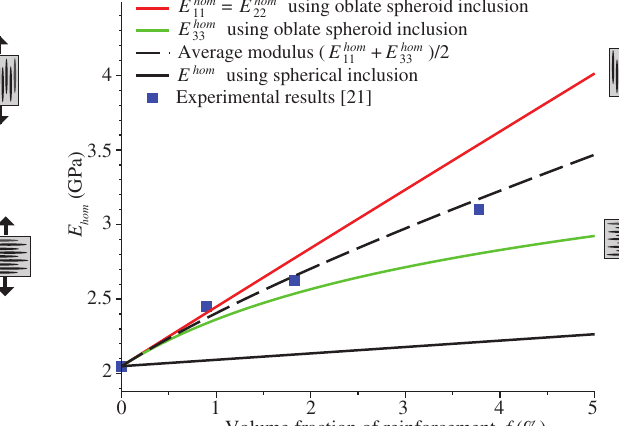
Figure 5 Comparison with experimental results from Luo et al. [21].